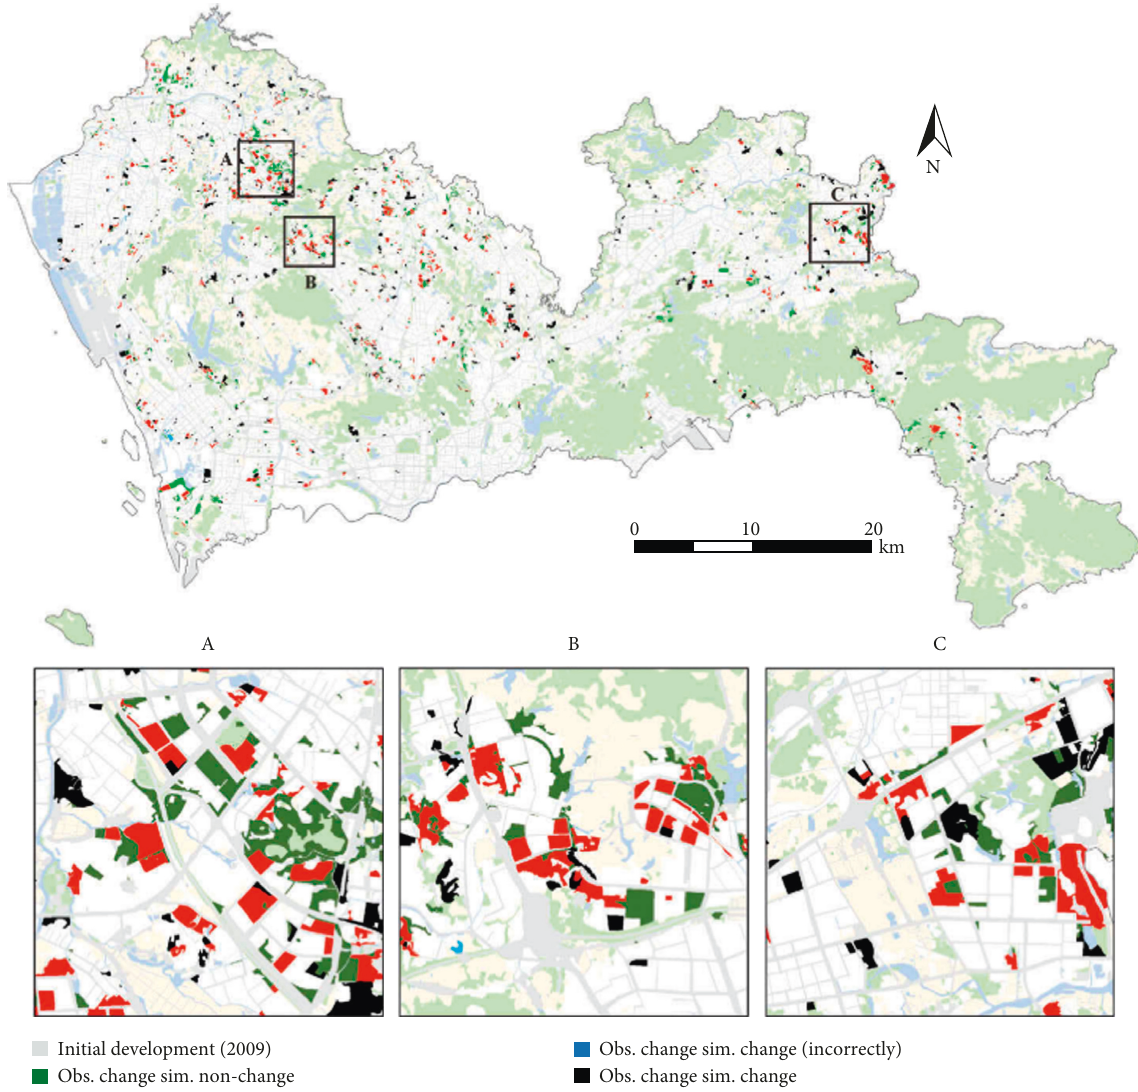
Figure 3: Three extended regions displaying the changes between projected and observed results. The disparities between the CA models are marked with circles